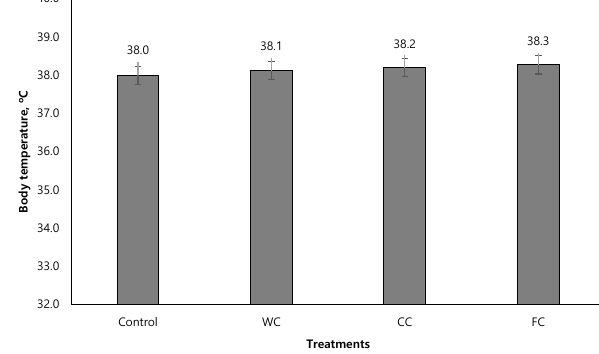
Figure 1. Effect of feeding Korean domestic corn by different grinding processing on body temperature of Holstein steers fed total mixed ration (TMR) as a basal. Treatments were TMR only (Control), TMR with whole corn grain (WC), TMR with coarsely ground corn grain (CC), and TMR with finely ground corn grain (FC), respectively.